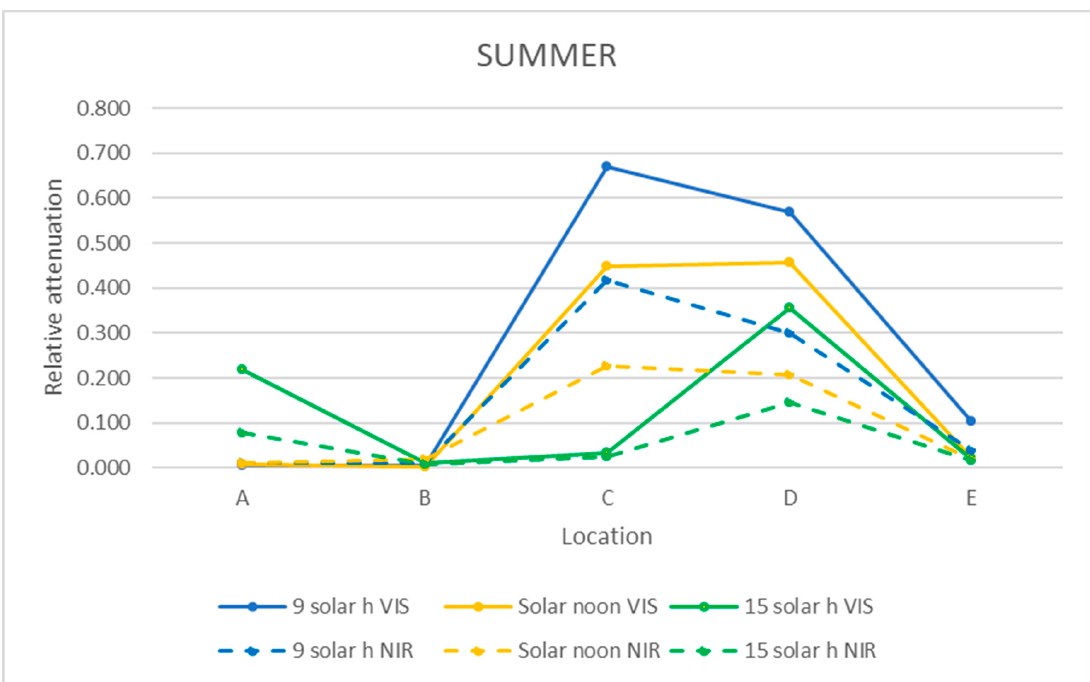
Figure 13. Representation of the mean relative attenuation for the VIS and NIR ranges for the 5 locations studied in summer at 3 times of day. Table 5. Mean relative attenuation values for the VIS and NIR bands in summer and at 3 times of day.